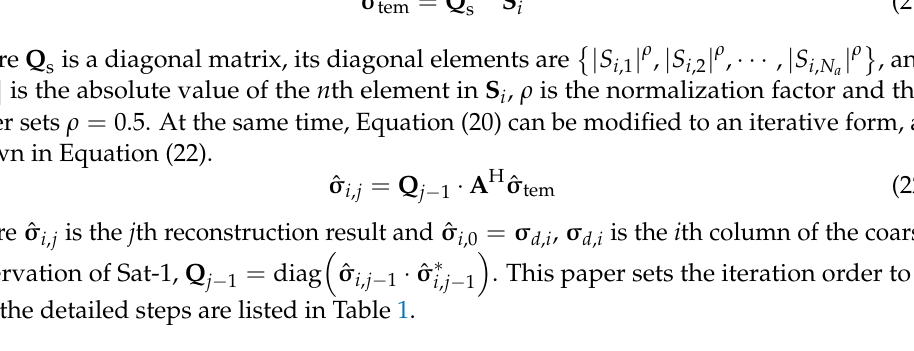
Table 1. Processing steps of the real airborne SAR data.